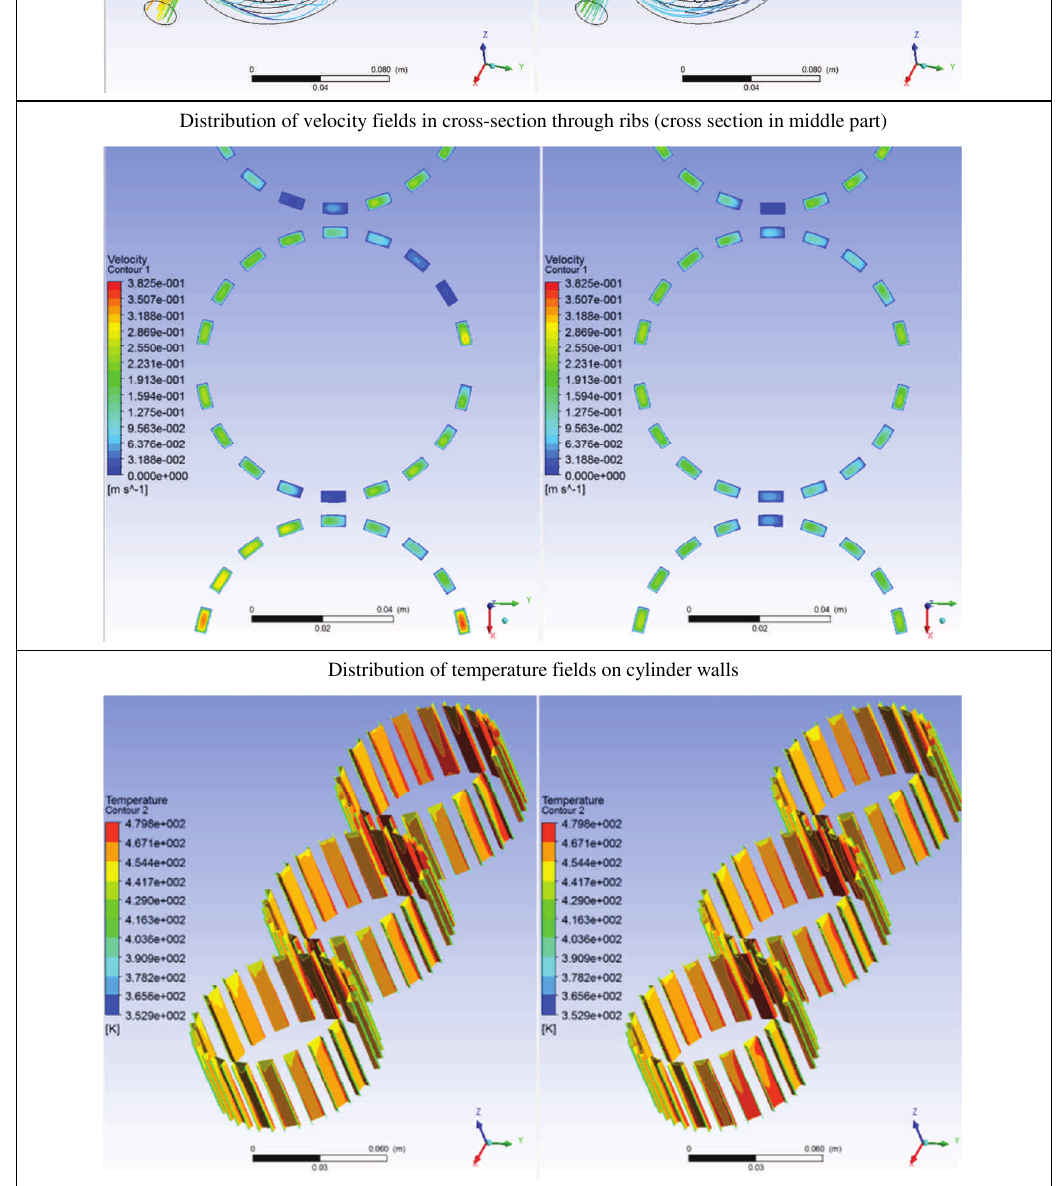
Fig. 14. Comparison of distribution of velocity fields across ribs and temperature fields for model with individualized flow in cylinders, one inlet and outlet (left side) and two inlets and outlets (right